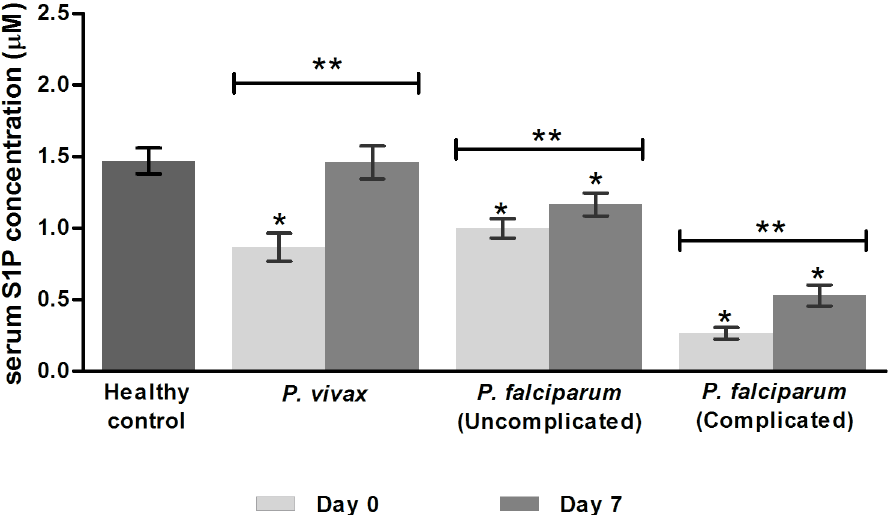
Fig 1. Serum S1P levels in malaria patients and healthy controls. S1P levels were measured in serum of malaria patients with P . vivax (n = 29), uncomplicated P . falciparum (n = 30) and complicated P . falciparum malaria (n = 13) on day 0 (pre-treatment) and day 7 (post-treatment) by quantitative ELISA. The healthy controls (n = 18) were used as a control group. Data are presentedwith mean ± SEM. * Comparison with healthycontrols using Mann-Whitney U test. ** Comparison betweenday 0 and day 7 using Wilcoxon signed- rank